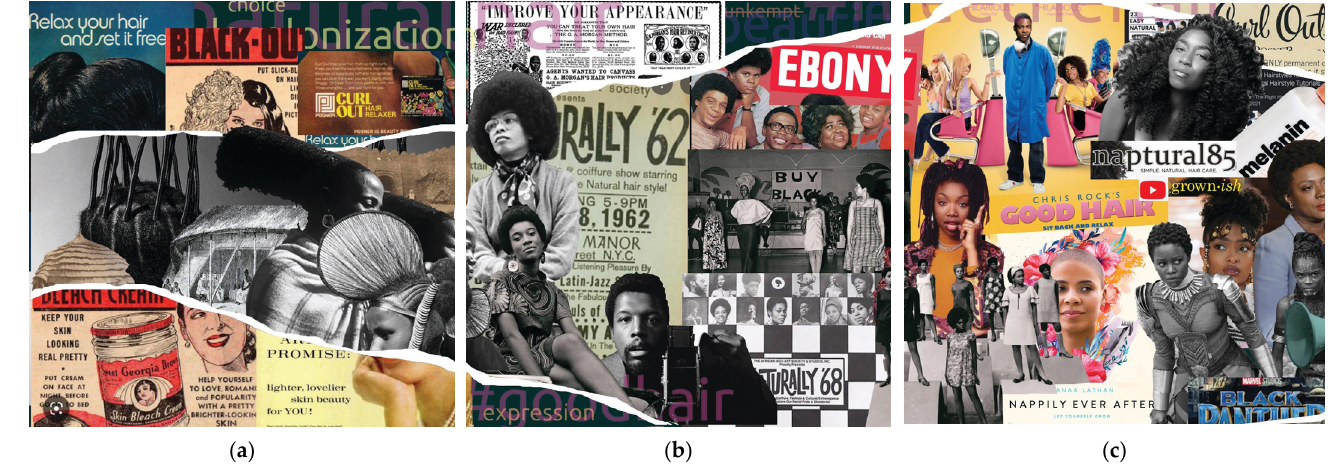
Figure 4. Natural Black Hair Movement, ( a ) pre-colonial culture poster, ( b ) post-colonial culture poster, ( c ) representation, created by Joan A. Murangira, 2022.